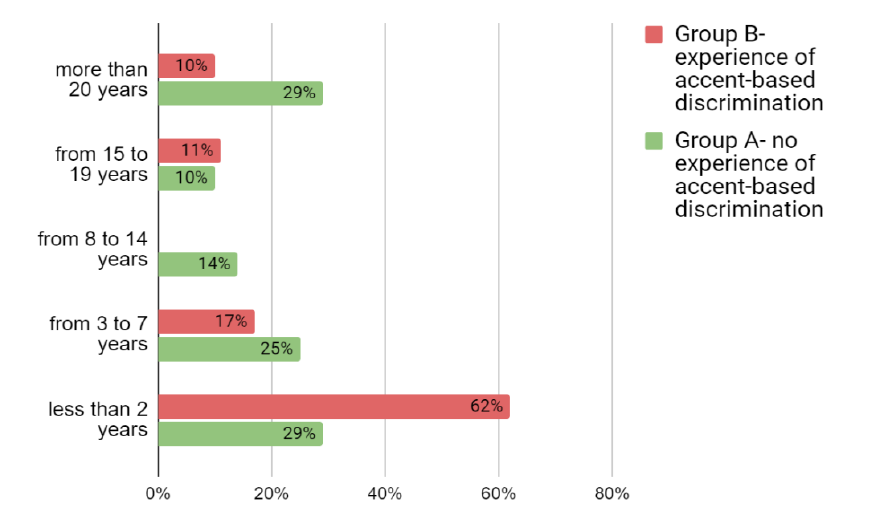
Fig. 4 — Comparative characteristic of duration of residence in